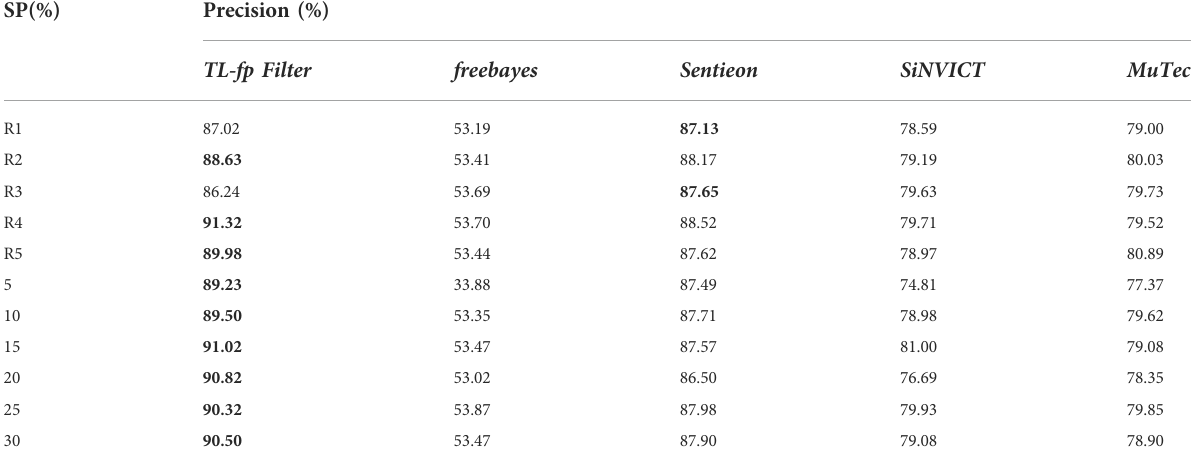
TABLE 3 Comparison results on mixed purity samples. SP(%)